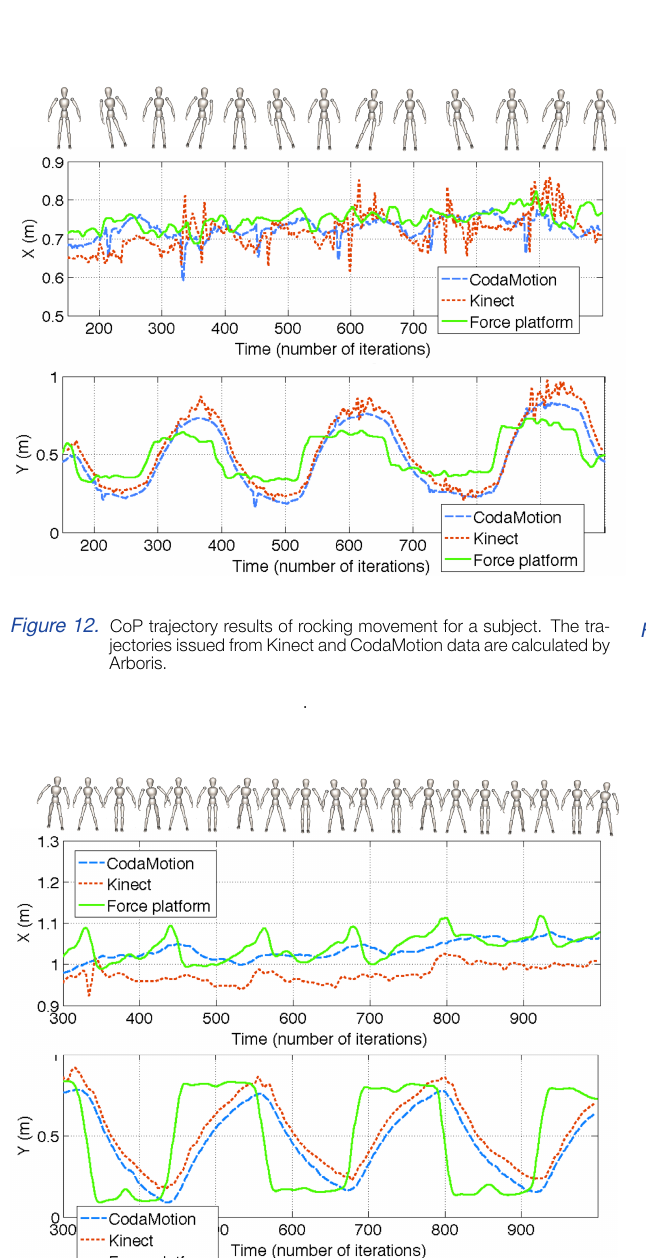
Figure 15. CoP error between the posturography platform measures and the trajectories provided by Arboris replaying Kinect data on X (top) and on Y (bottom) for all the subjects. .